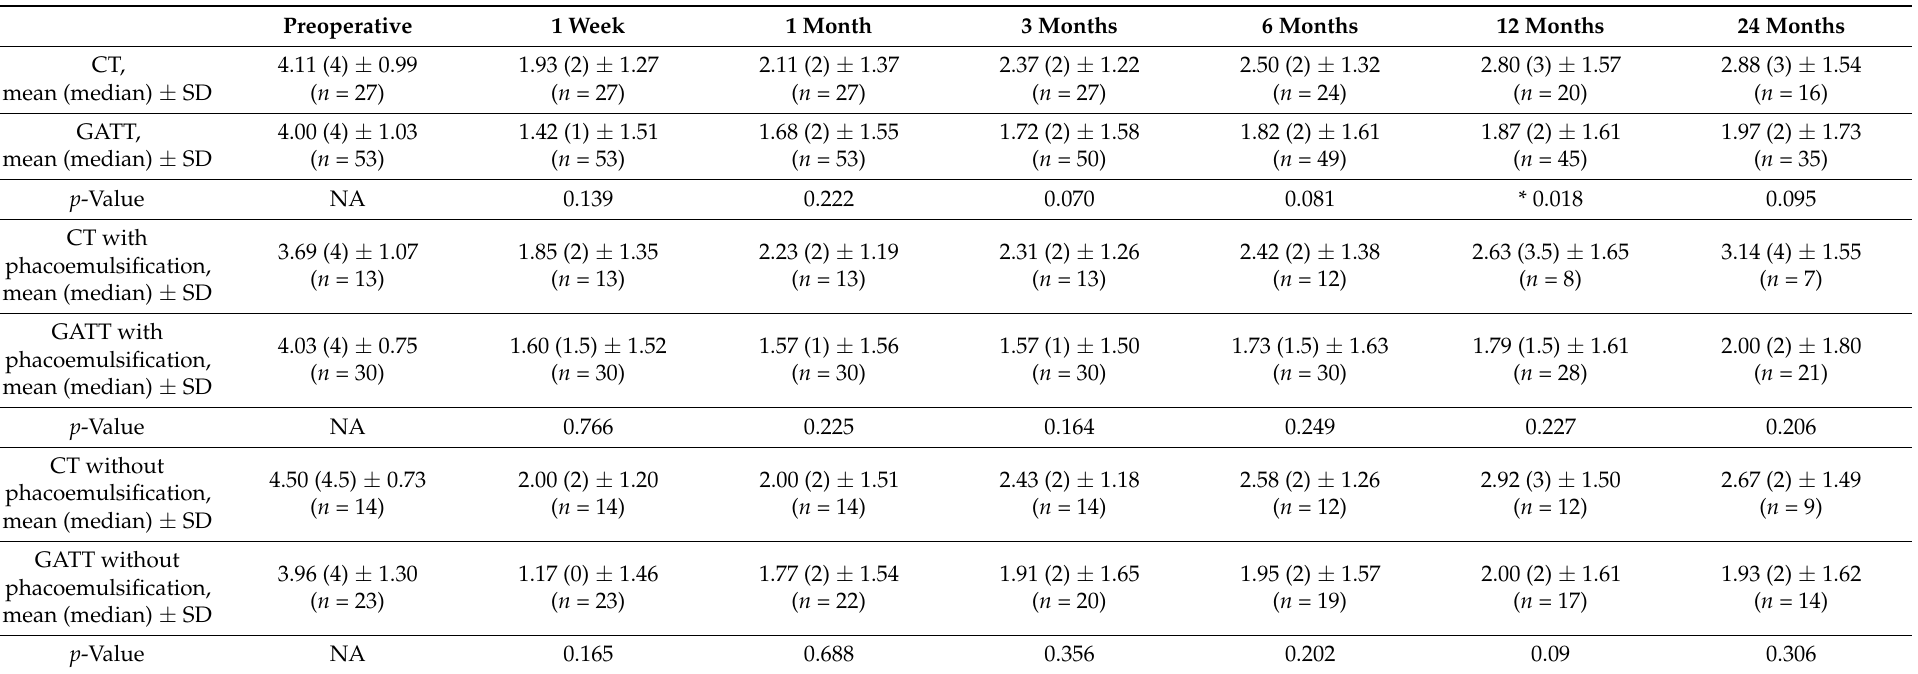
Table 3. Pre- and postoperative number of glaucoma medications in the CT and GATT with and without